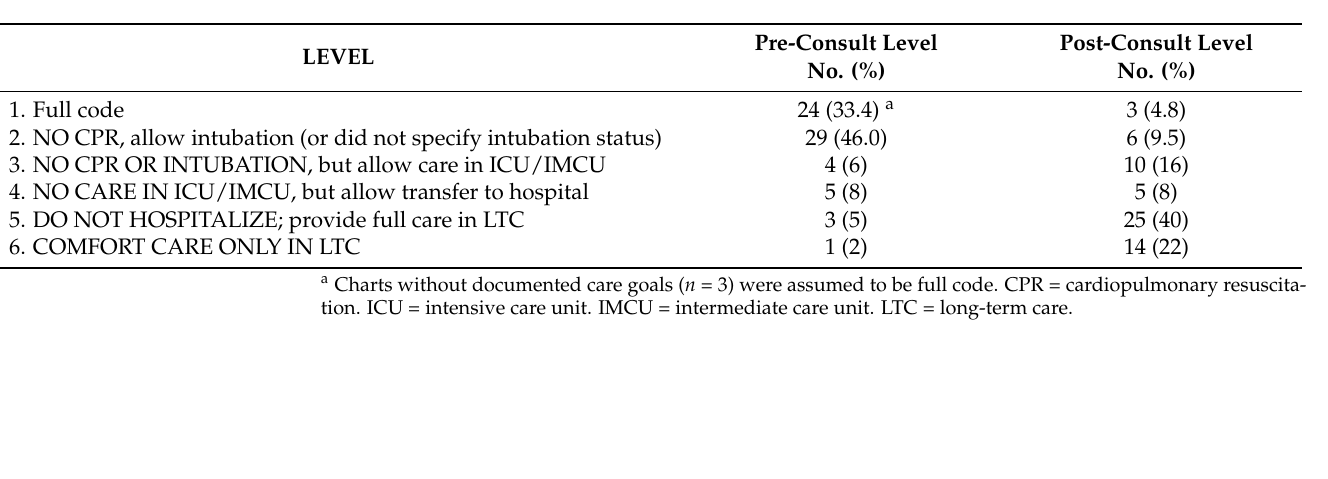
Table 2. Goals of care outcomes by level ( n =